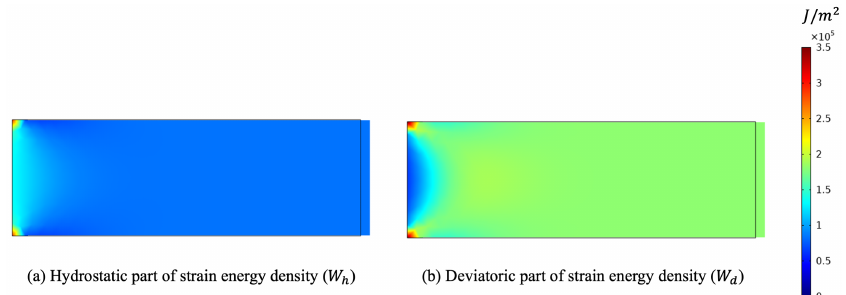
Figure 10. Deformed shape for the tensile test (plots were obtained with a scale factor of 5).